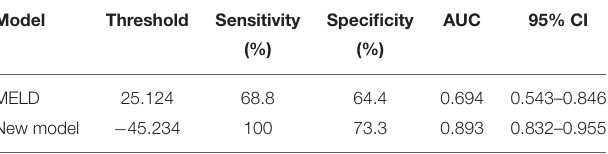
TABLE 11 | Comparison of the two models for predicting fetal mortality.